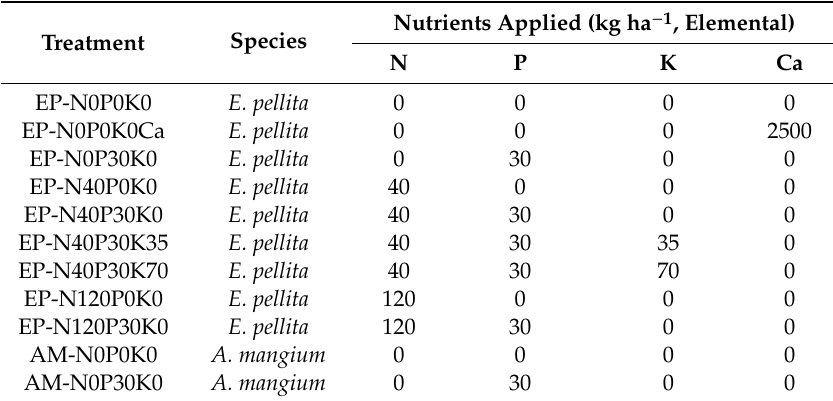
Table 2. Treatments applied in the Core